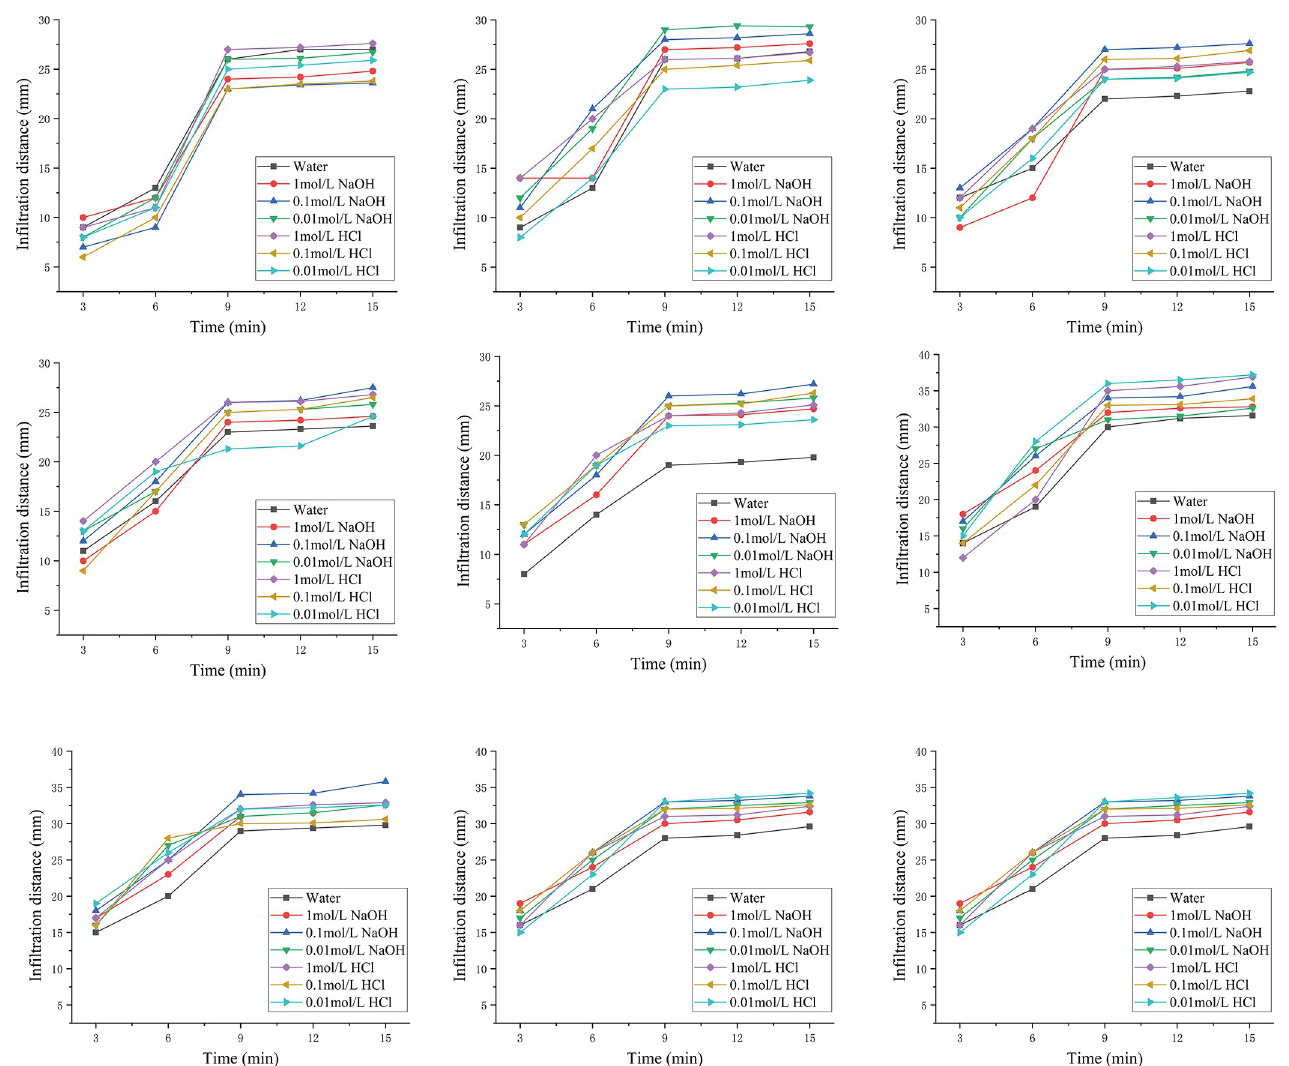
Fig 17. Infiltration of the mud film of weathered soil in the 9 groups (A) 8 mm naturally weathered red-bed soil film; (B) 11 mm naturally weathered red-bed soil film; (C) 14 mm naturally weathered red-bed soil film; (D) 20 mm naturally weathered red-bed soil film; (E) 25 mm naturally weathered red-bed soil film; (F) 30 mm naturally weathered red-bed soil film; (G) 32 mm naturally weathered red-bed soil film; (H) 35 mm naturally weathered red-bed soil film; (I) 8 mm naturally weathered red-bed soil